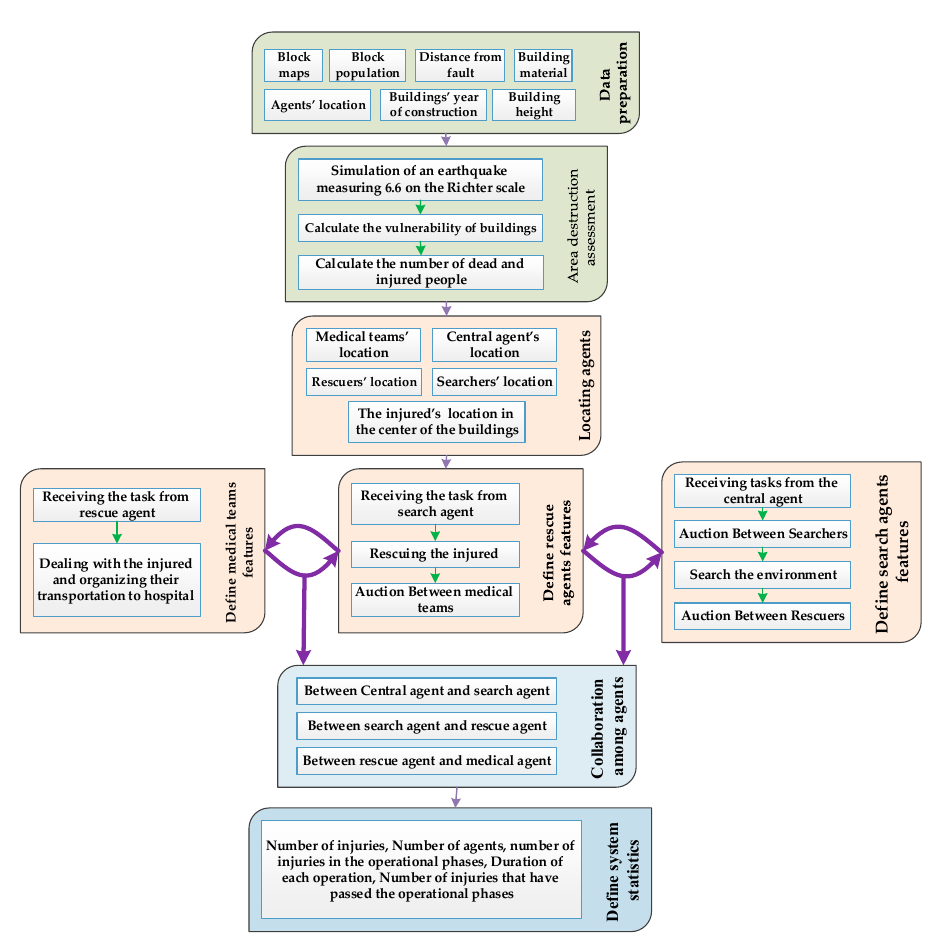
Figure 2. Implementation steps of the simulated search and rescue operations system after an